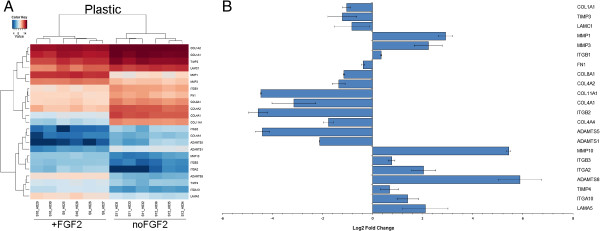
FGF2 affects expression levels of genes associated with extracellular matrix remodelling. A. Heat map showing expression levels of select genes as identified by microarray analysis. B. qRT-PCR validation of microarray data for select genes. Expression levels were normalized to ACTB and are represented as log2 Fold Change (FGF2-treated compared to untreated). Error bars represent SEM. qRT-PCR for COL1A2 did not show change in the expression levels.